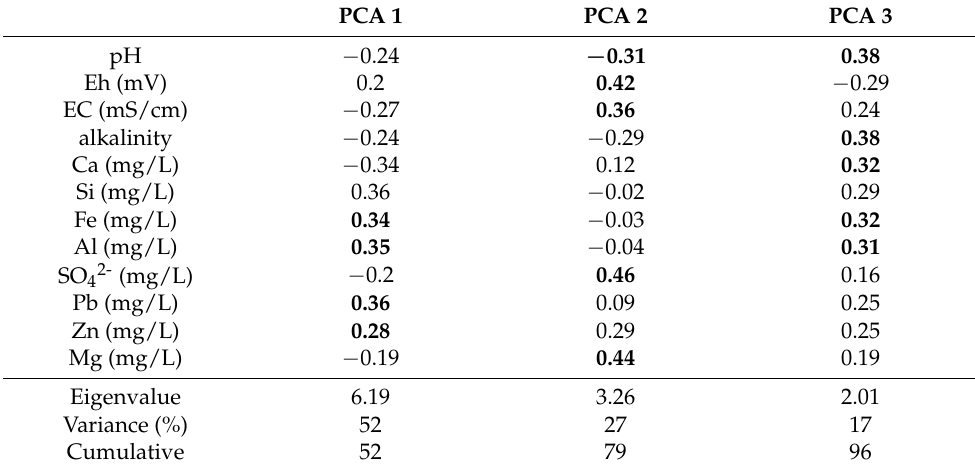
Table 4. Principal Component Analysis (PCA) for Water-Soluble Pb and Zn, including Total Variance, Eigenvalue, and Cumulative Frequency.